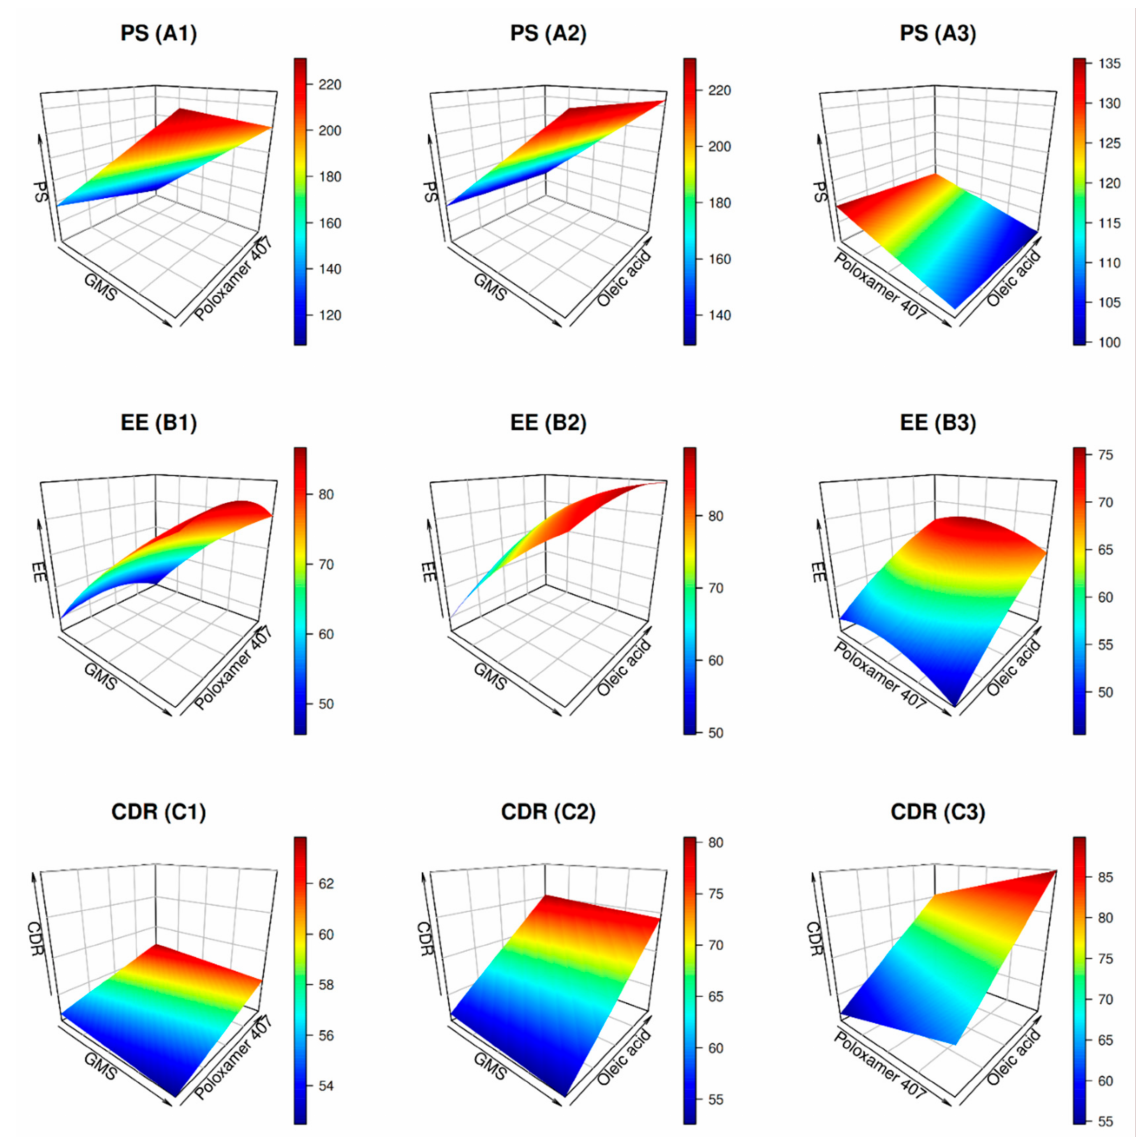
Figure 2. 3D plots for the effects of GMS amount (mg), poloxamer 407 concentration (% w / w ), and oleic acid amount (mg) on BER-CTS-NLCs size (PS), entrapment (EE%), and cumulative drug released